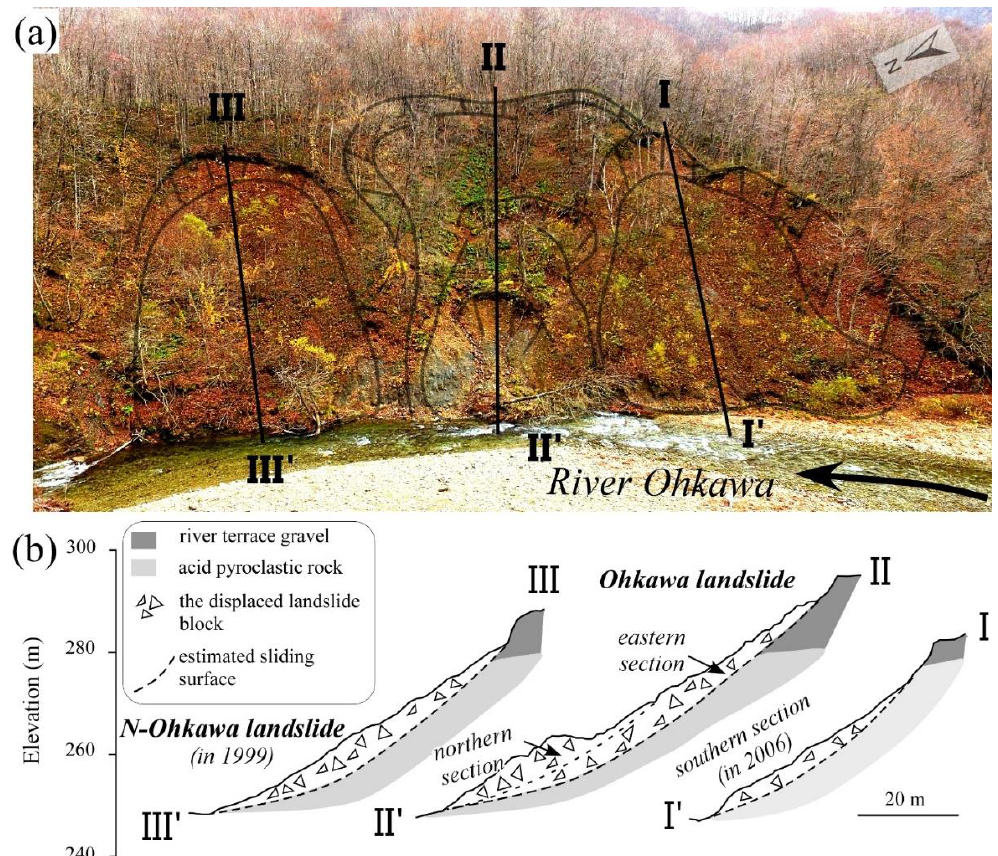
Figure 2. Topography and geological cross-sections of the studied landslide slopes. ( a ) A photograph of the study area. ( b ) Geological cross-sections of the N-Ohkawa landslide (III–III’), the eastern and northern sections of the Ohkawa landslide (II–II’), and the southern section of the Ohkawa landslide (I–I’). The photograph was taken in 2017. The cross-sections are based on the LiDAR DEM.